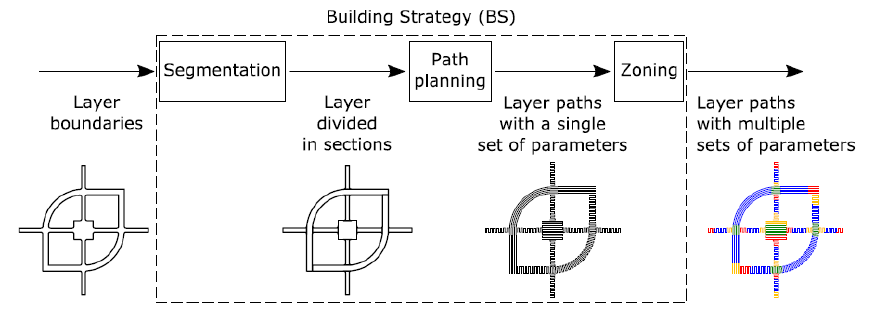
Figure 2. Flowchart of the MPP method: layer segmentation, path planning, and zoning, by Michel et al. [10].